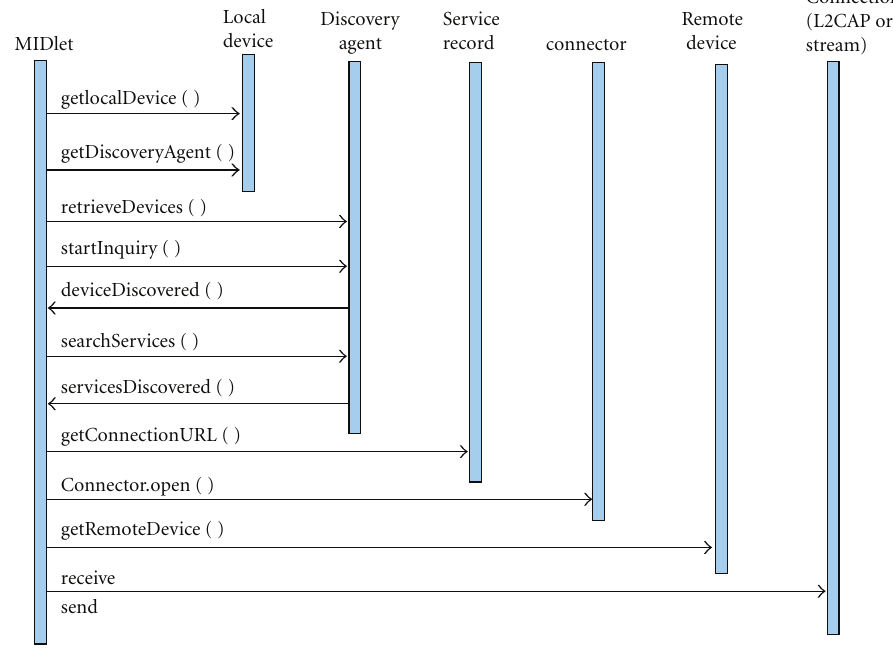
Figure 3: Connection steps through Bluetooth.